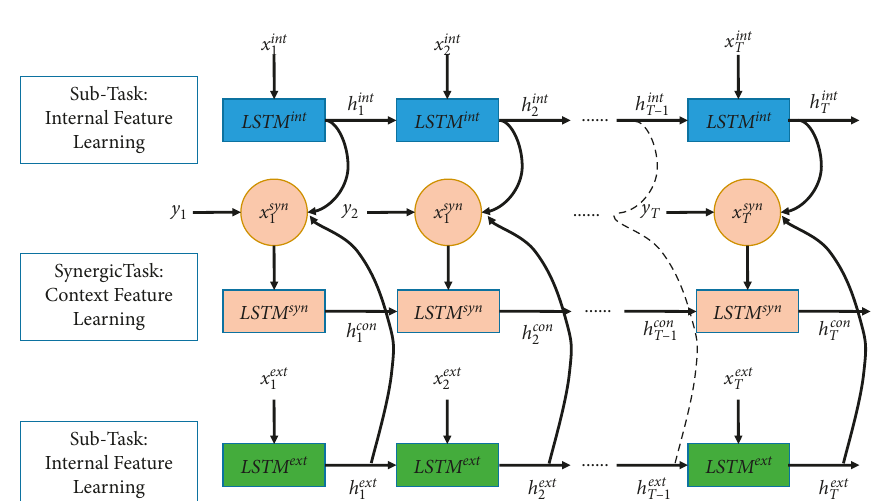
Figure 6: Structure of multitask LSTM encoder.